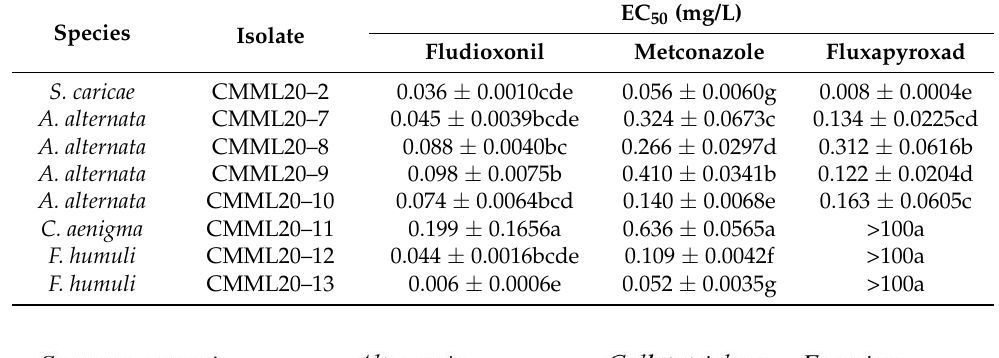
Table 1. Fungicide sensitivity of all fungal isolates and their EC 50 value calculated in a plate assay. The fluxapyroxad showed effective control activity against the pathogens but not endophytes identified in this study. Different letters indicate statistically significant difference of the values.